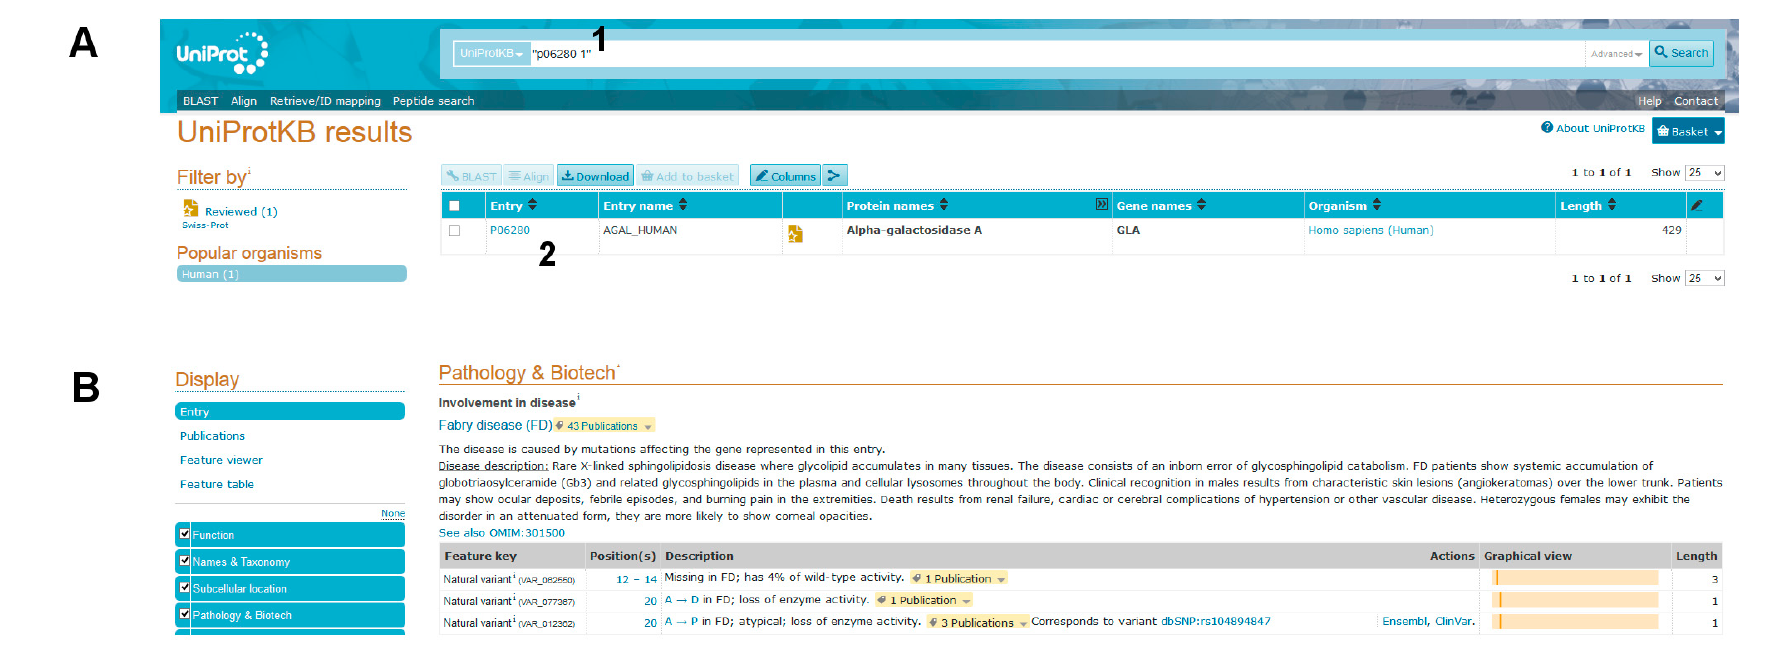
Figure 8. UniProt analysis. ( A ) input data. ( B ) a selection of the output, a list of natural variants of AGAL (partial view).